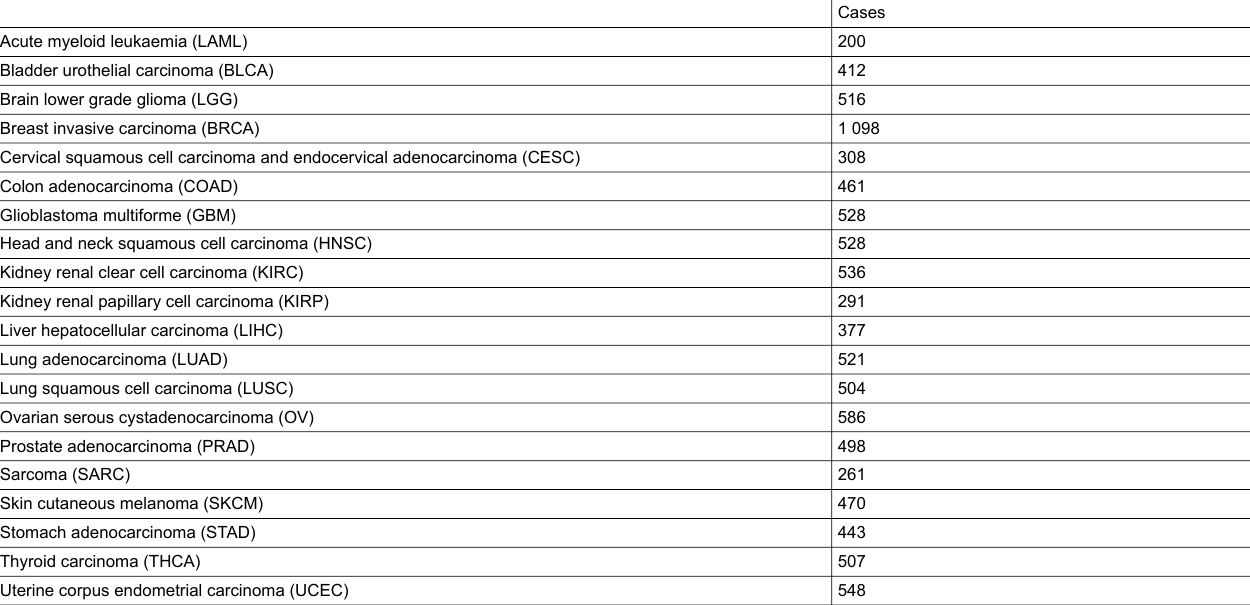
Table 1: Cancer types with data available via The Cancer Genome